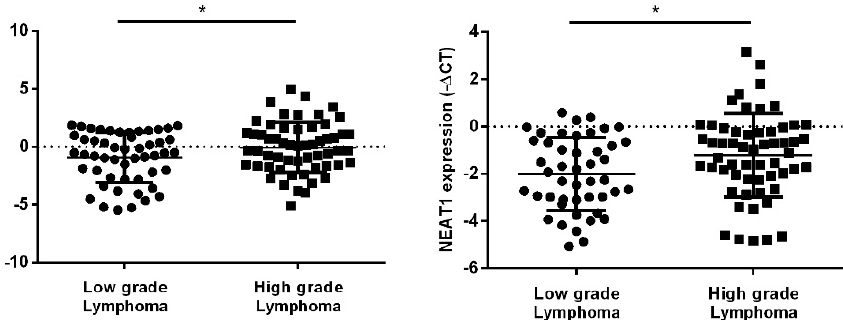
Figure 6. Expression levels of MALAT1 and NEAT1 in plasma samples of NHL patients’ groups according to lymphoma grade. MALAT1 and NEAT1 presented higher plasma levels in patients diagnosed with high grade lymphoma compared to low grade lymphoma ( p = 0.035 and p = 0.018, respectively). * p <